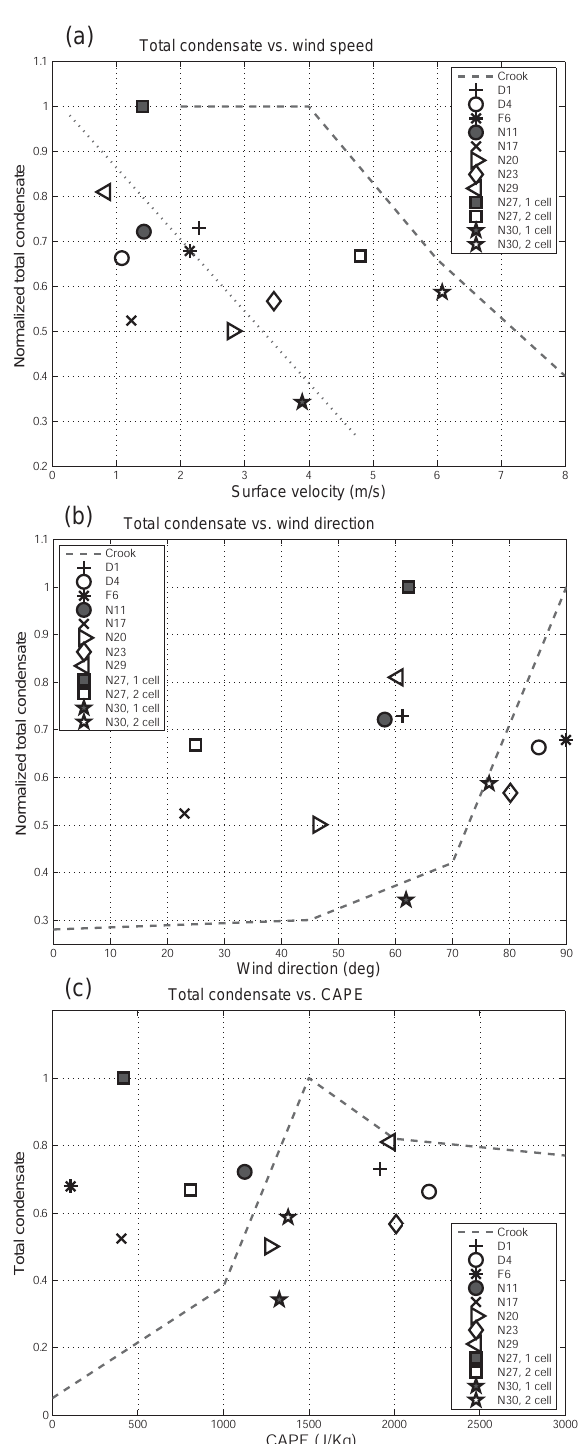
Figure 9. Crook’s test: normalized total condensate extracted at the maximum stage and averaged into the Hector volume versus surface wind speed (a) , surface wind direction (b) and CAPE (c) , extracted at the start time. The dashed gray line reports the Crook ideal trend, and the light gray dotted line in panel (b) reports the derived real trend.